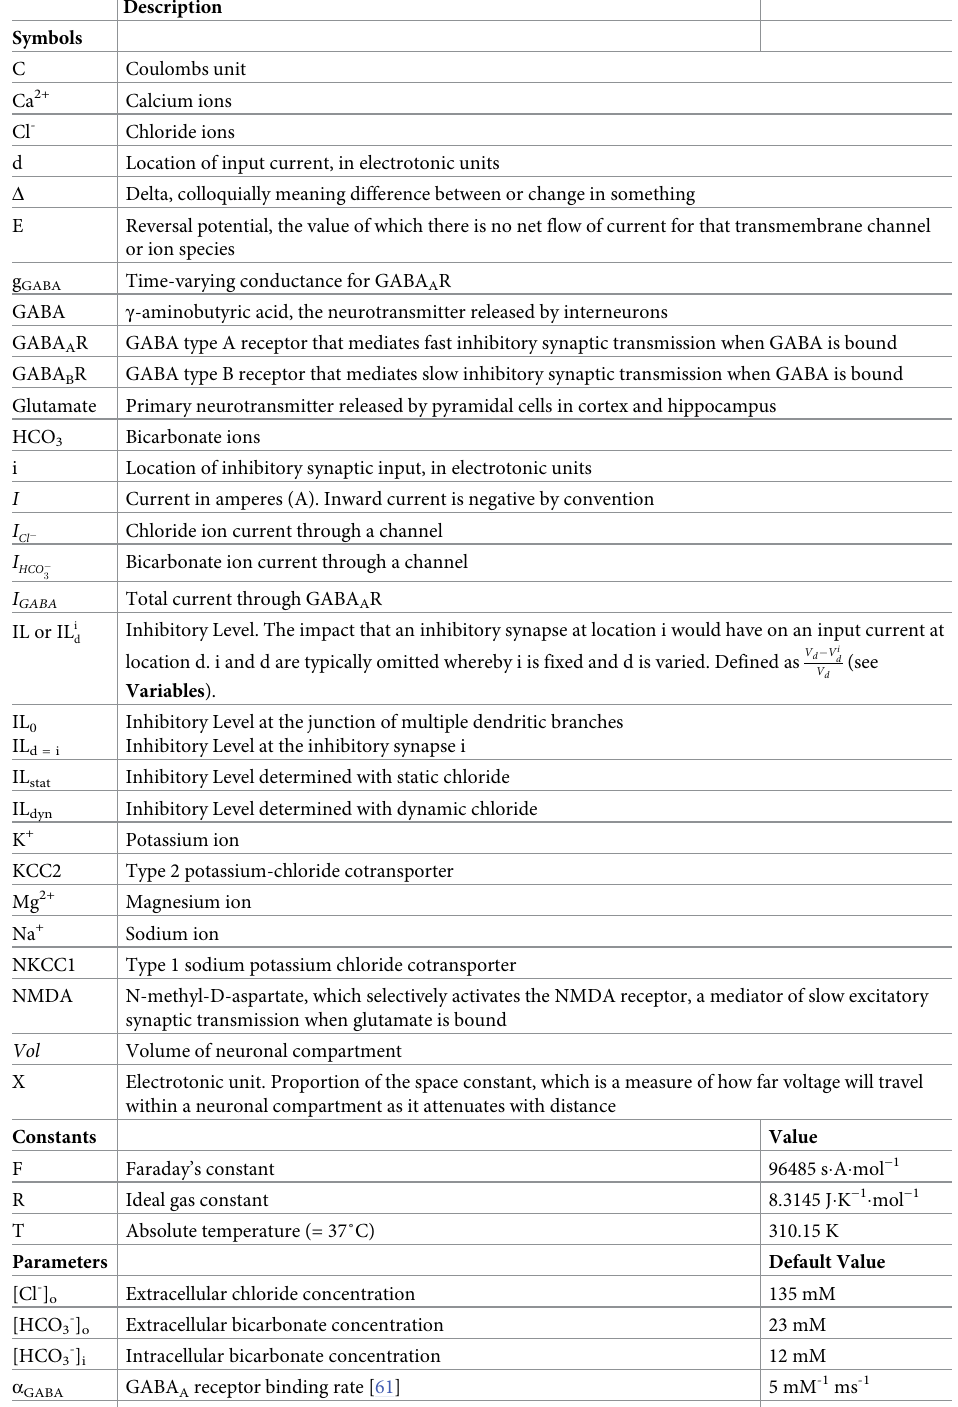
Table 1. Symbols, constants, parameters, and